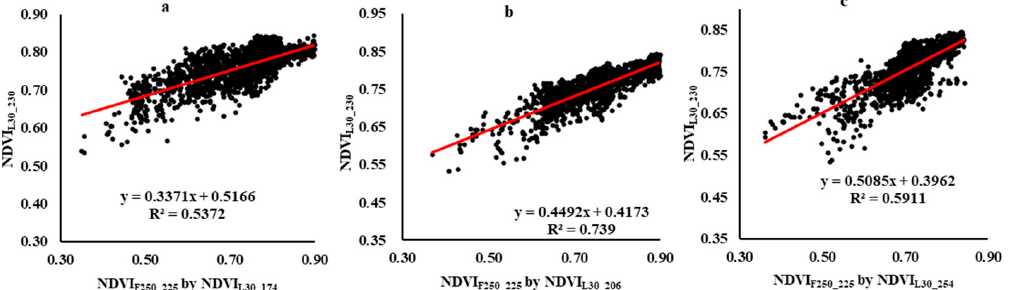
Figure 13. Scatter plots of NDVI F250_225 using different reference dates versus NDVI L30_230 . NDVI L30_230 versus NDVI F250_225 using ( a ) NDVI L30_174 , ( b ) NDVI L30_206 , and ( c ) NDVI L30_254 for all pixels of 3 plots). Table 3. Results of linear regression between the fusion product NDVI F250_225 using different refer- ence dates and NDVI L30_230 in three plots.